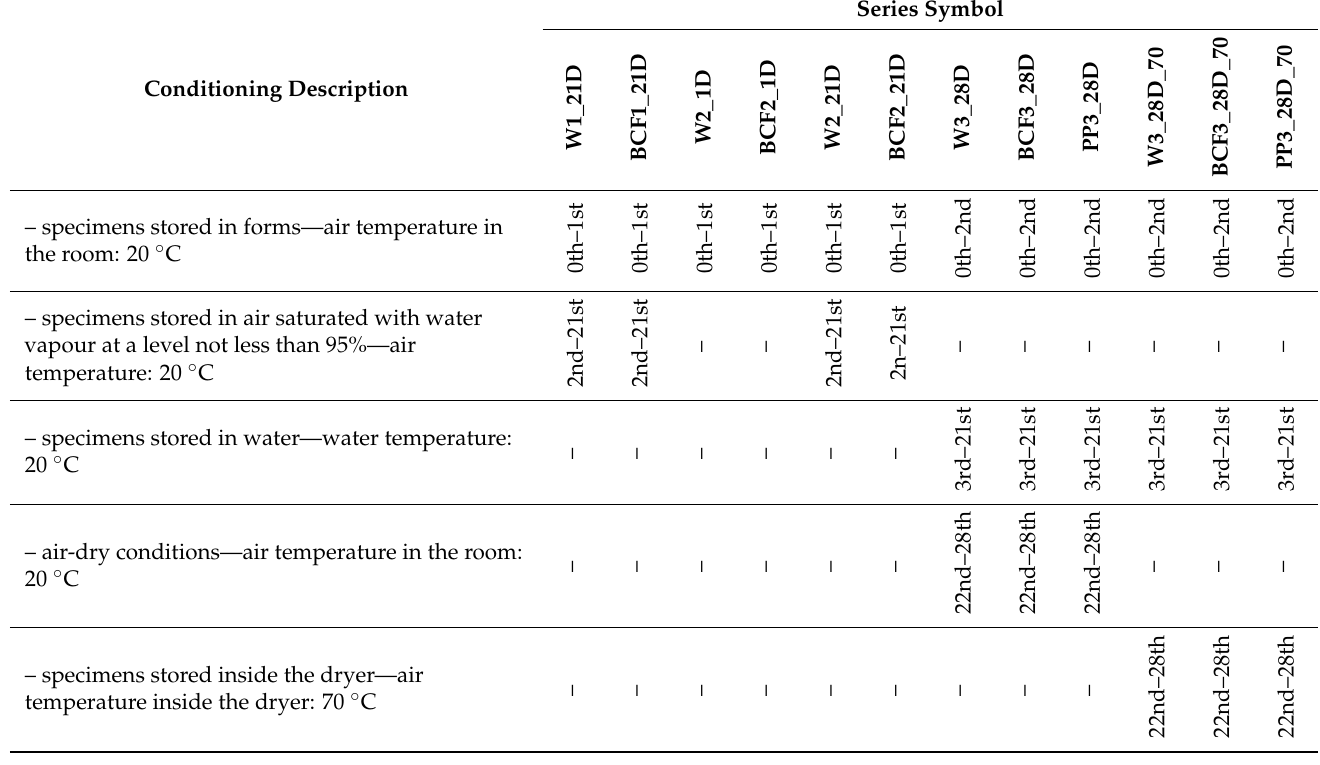
Table 4. Conditions and storage time for each series of samples.